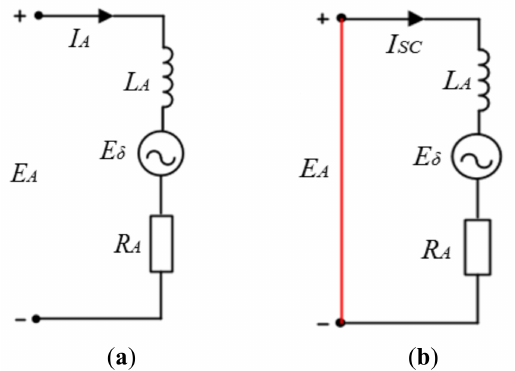
Figure 2. Equivalent circuit. ( a ) Healthy winding. ( b ) Single phase short circuit fault. When a short circuit occurs at the winding end, the terminal voltage is 0, and the voltage equation when a fault occurs is shown in Equation